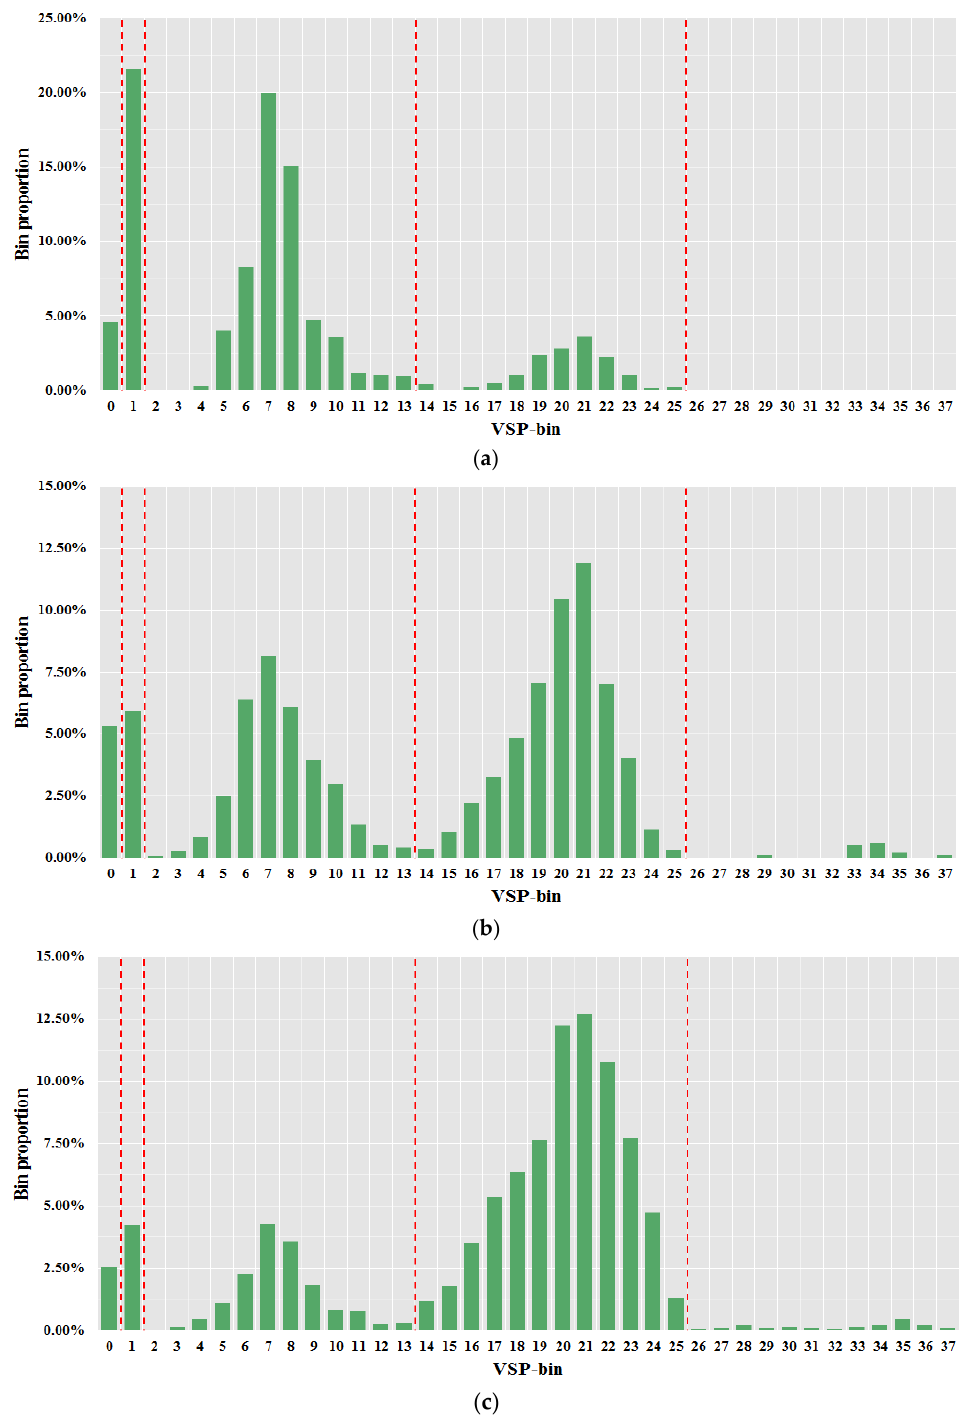
Figure 11. The VSP-bin frequency distributions of different typical vehicle driving cycles; ( a ) The VSP-bin frequency distributions of low-speed driving condition; ( b ) The VSP-bin frequency distributions of middle-speed driving condition; ( c ) The VSP-bin frequency distributions of high-speed driving condition; the areas divided by 4 red dotted lines from left to right corresponds to 5 speed intervals (i.e., “Deceleration”, “Idling”, “Low speed”, “Middle speed”, and “High speed”) in VSP-bin division standard respectively. Table 5. The distribution frequency of different vehicle typical driving cycles in different speed intervals of VSP-bins.